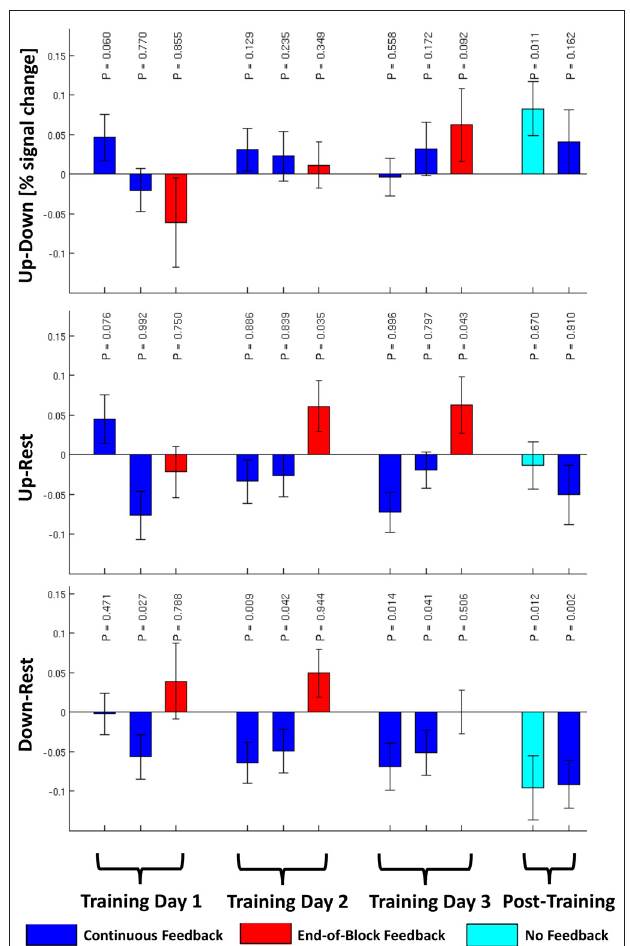
FIGURE 2 | The group averaged contrasts for “UP” against “DOWN”, “UP” against “REST”, and “DOWN” against “REST” conditions are plotted for each of the 11 runs ( ± 1 SEM) for N = 32 subjects. P -values uncorrected for multiple comparisons for the 1-tailed, one-sample t -test are given using the alternative hypotheses that “UP” > “DOWN”, “UP” > “REST”, and “DOWN” < “REST”.